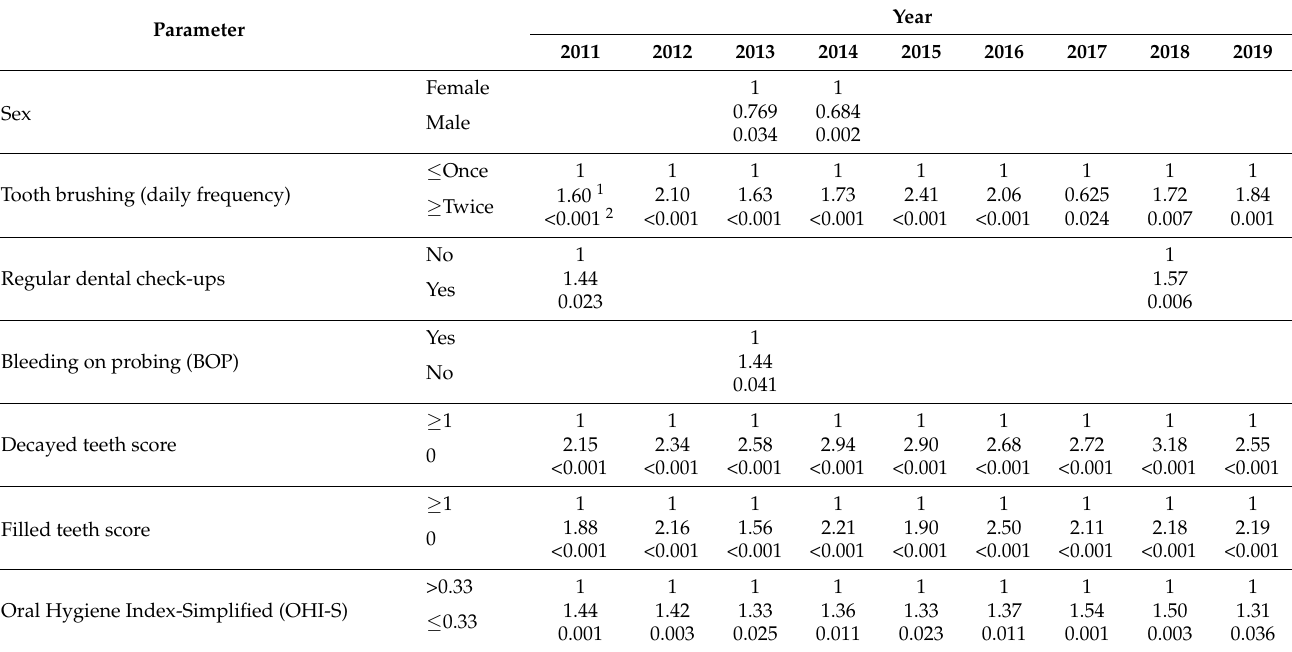
Table 4. Factors associated with self-rated oral health (very good, good, and fair) on logistic regression analyses on a yearly basis from 2011 to 2019, Japanese university